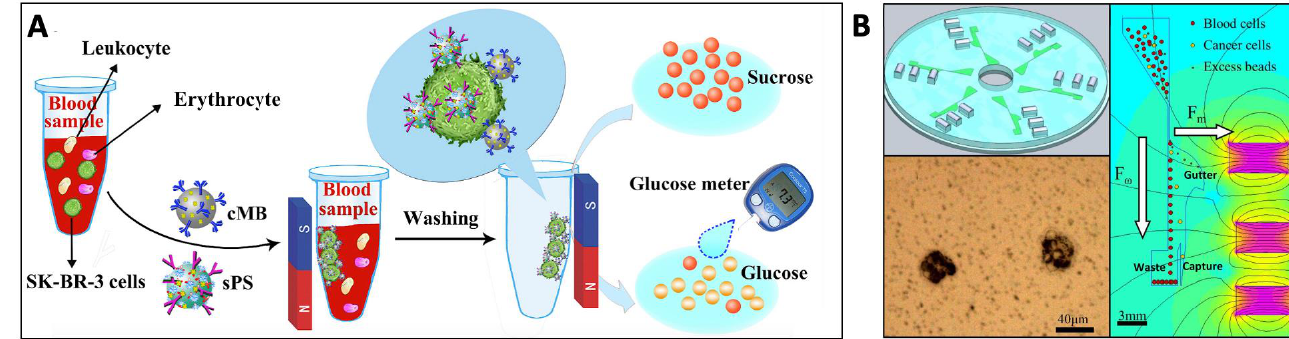
Figure 20. Towards POC detection of CTCs. ( A ) Dual recognition strategy and glucometer-based signal readout for CTC detection in whole blood. Reprinted with permission from ref.[250] © 2019 Elsevier B.V. All rights reserved. ( B ) Lab-on-a-disc platform for separation and subsequent detection of cancer cells using bright-field imaging. Reprinted with permission from Ref. [199]© 2014 International Society for Advancement of Cytometry.